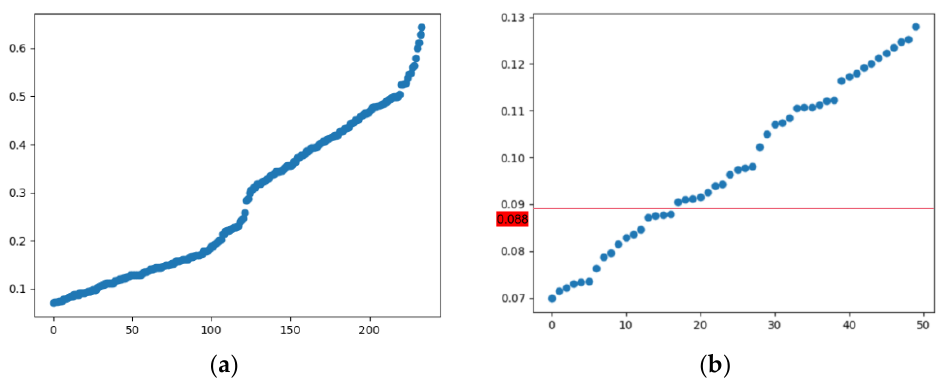
Figure 5. Cosine similarities distribution of adjacent themes: ( a ) Cosine similarities distribution among all adjacent themes; ( b ) distribution of cosine similarities for the top 50.